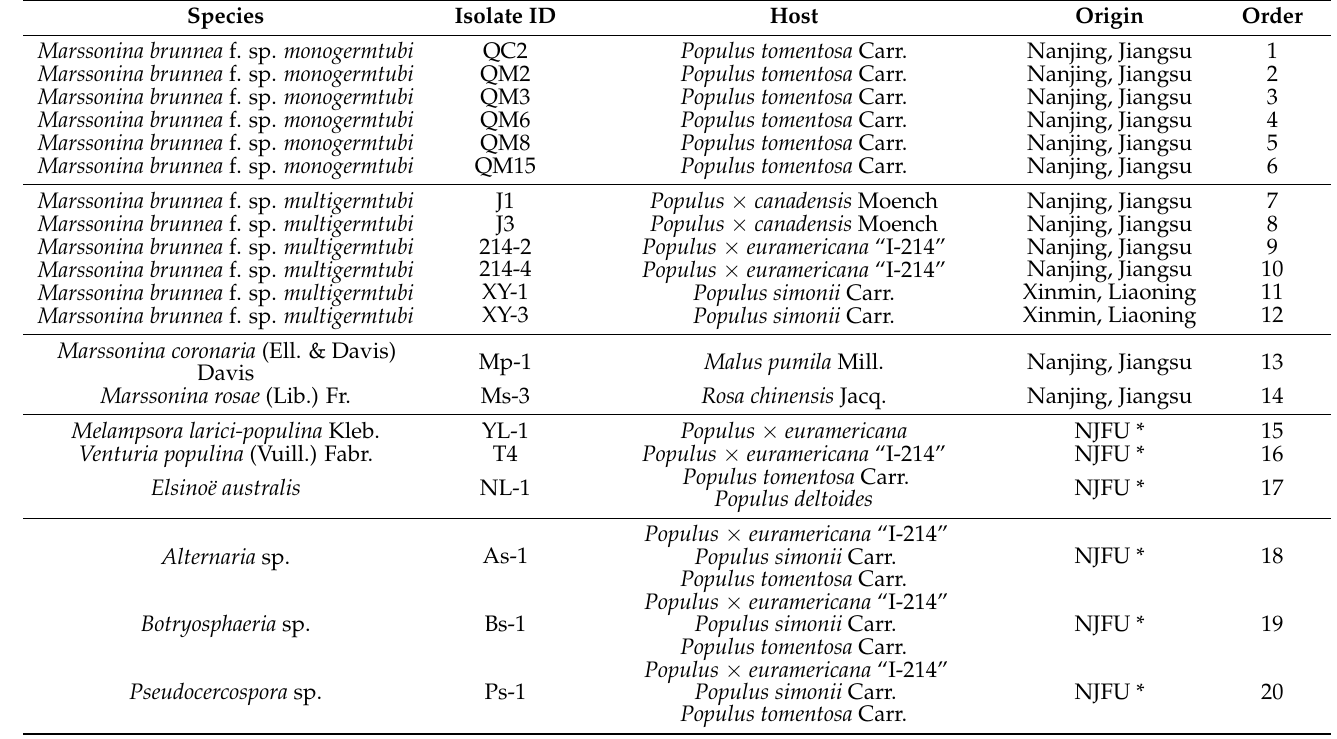
Table 2. List of fungal strains used in this